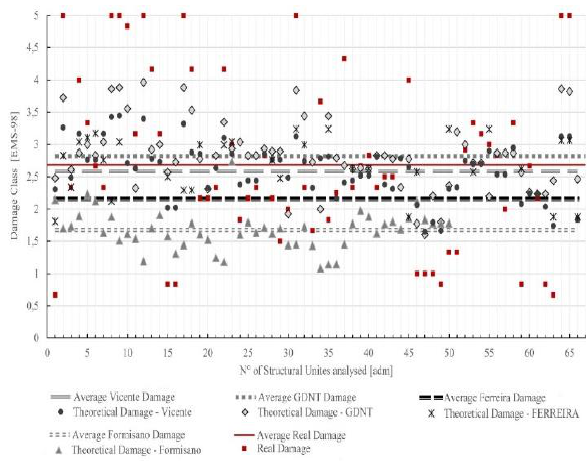
Figure 13. Comparison between the Real Damage detected in the case study and the Theoretical Damage evaluated through different vulnerability methodologies for each SU.